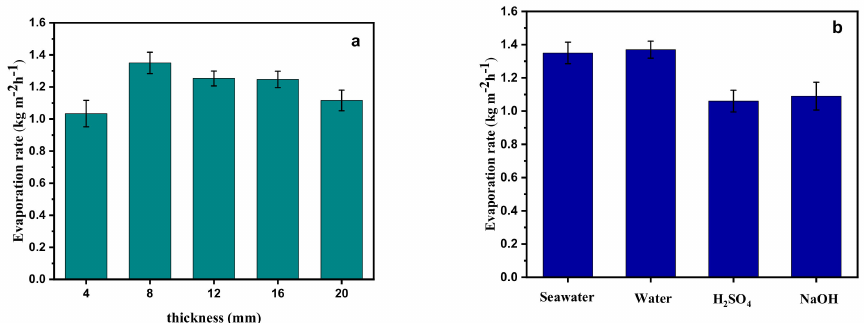
Figure 8. ( a ) Evaporation rate of PNRS with different thickness; ( b ) evaporation rate of PNRS in seawater, tap water, 1 M H 2 SO 4 and 0.5 M